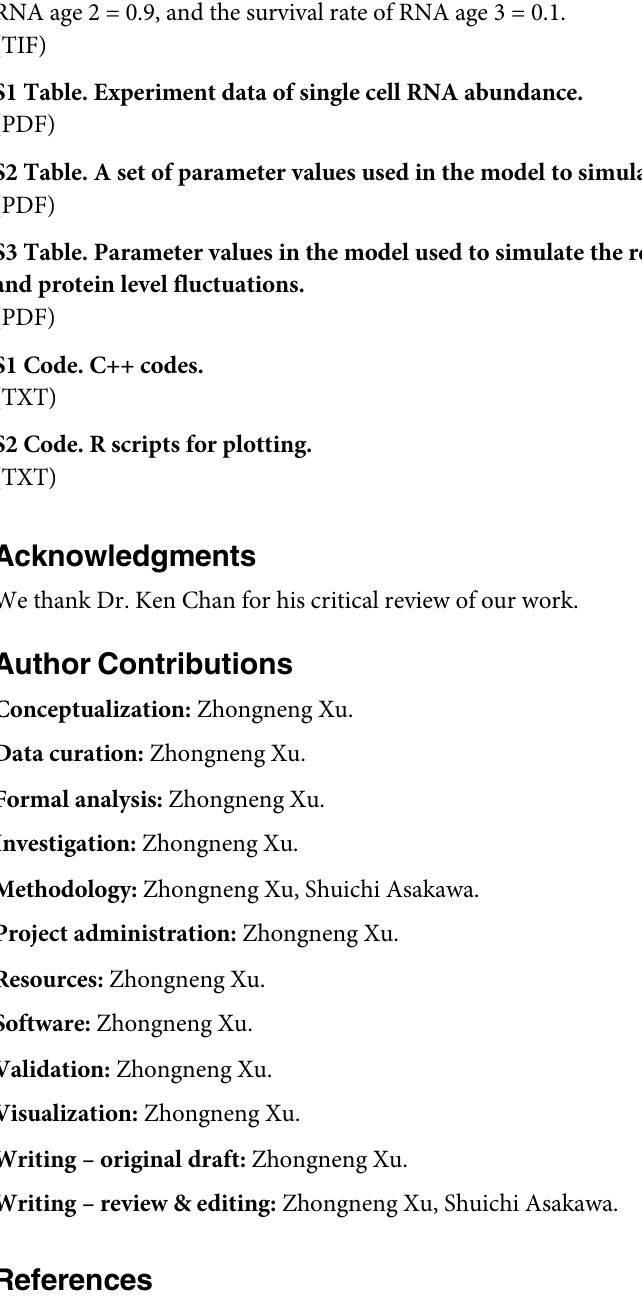
S1 Table. Experiment data of single cell RNA abundance. S2 Table. A set of parameter values used in the model to simulate RNA level fluctuations. S3 Table. Parameter values in the model used to simulate the relationship between RNA and protein level